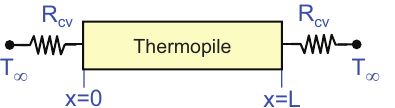
Figure 3. Thermopile of thickness L with convection losses at its surfaces. A current density J ( t ) is flowing inside the